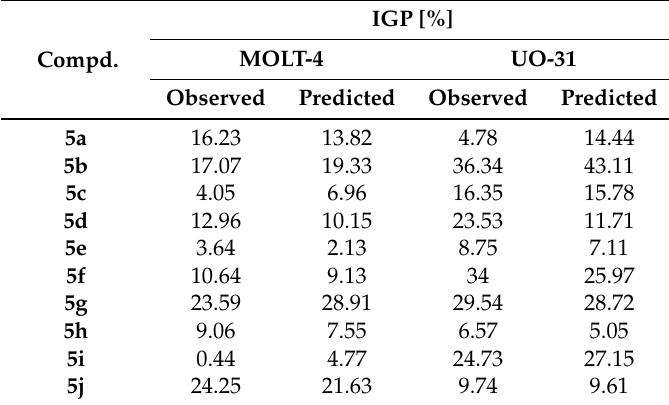
Table 4. Comparison of observed IGP values (anticancer activity) and those predicted by QSAR models for MOLT-4 and UO-31 cell lines.